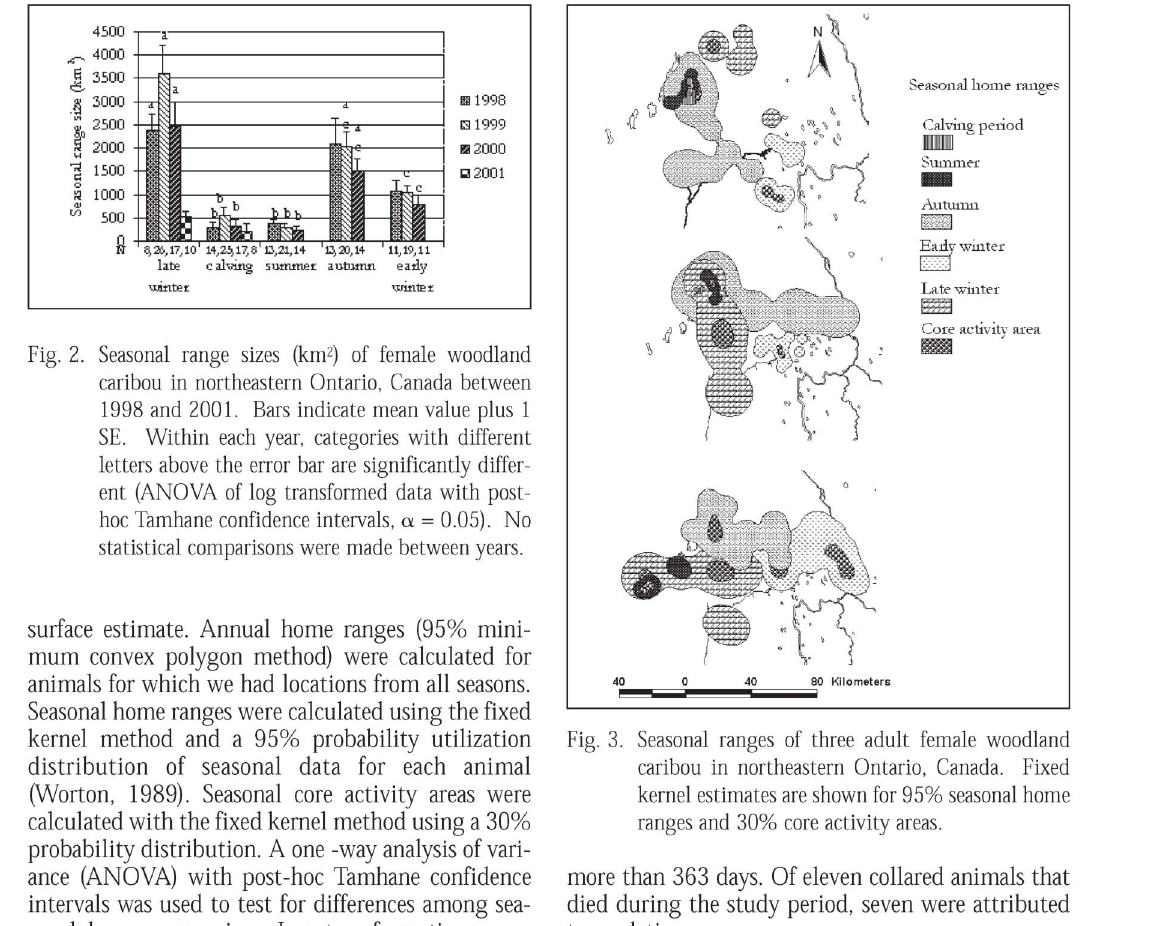
Fig. 3. Seasonal ranges of three adult female woodland caribou in northeastern Ontario, Canada. Fixed kernel estimates are shown for 95% seasonal home ranges and 30% core activity